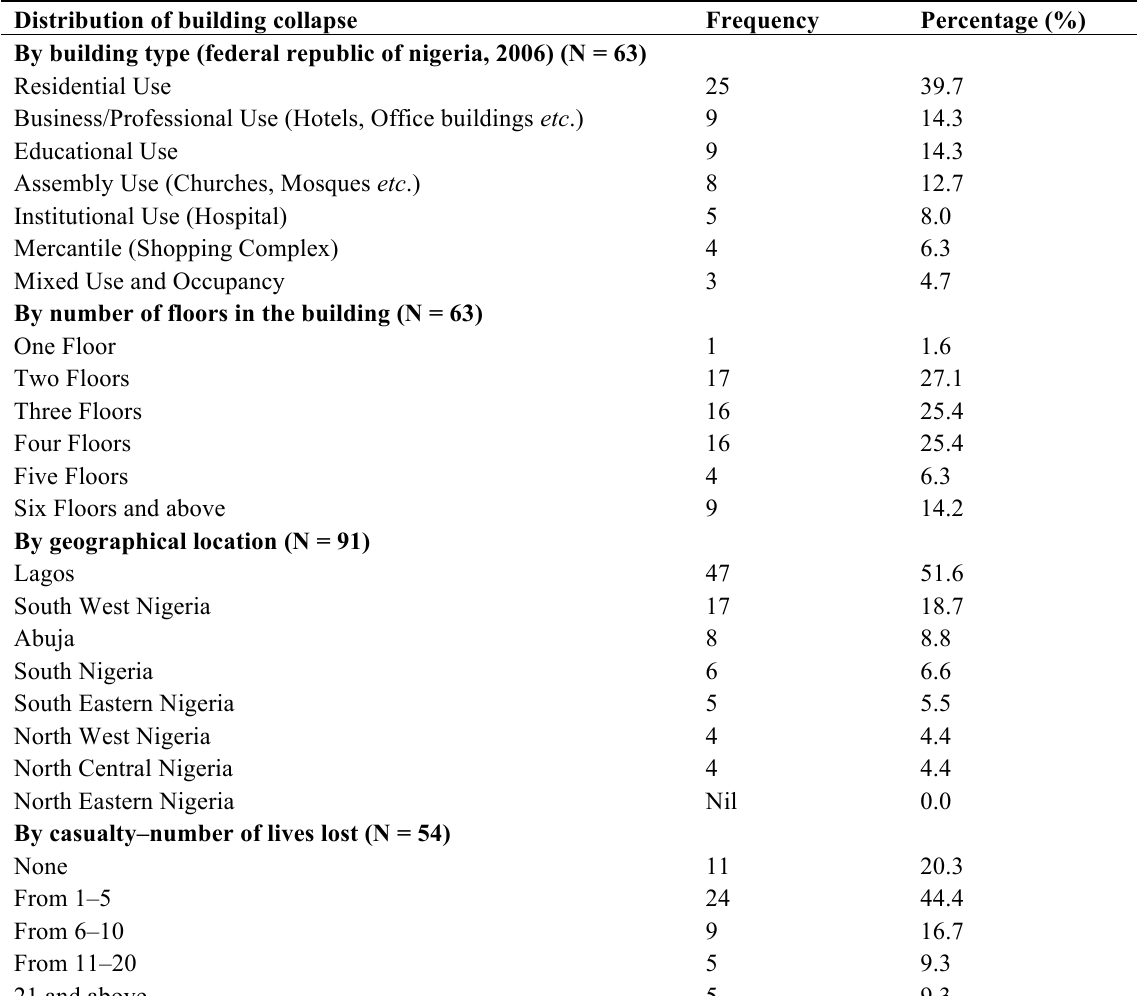
Table 1. Reported cases of building collapse (1974–2010) according to type, number of floors, geographical location and casualties